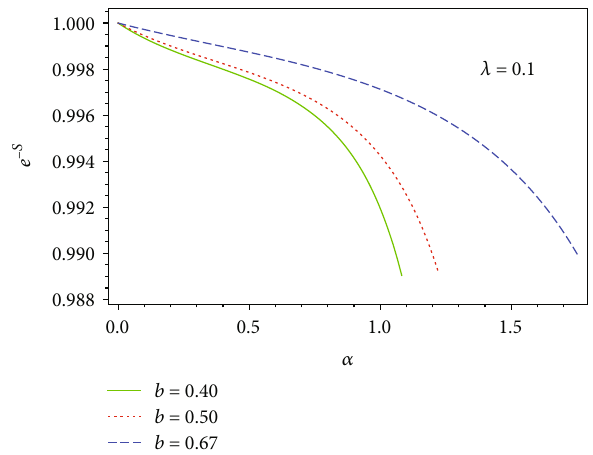
Figure 10: Considering pair production rate at fi nite temperature, di ff erent probe brane positions, and fi xed value of scale parameter.